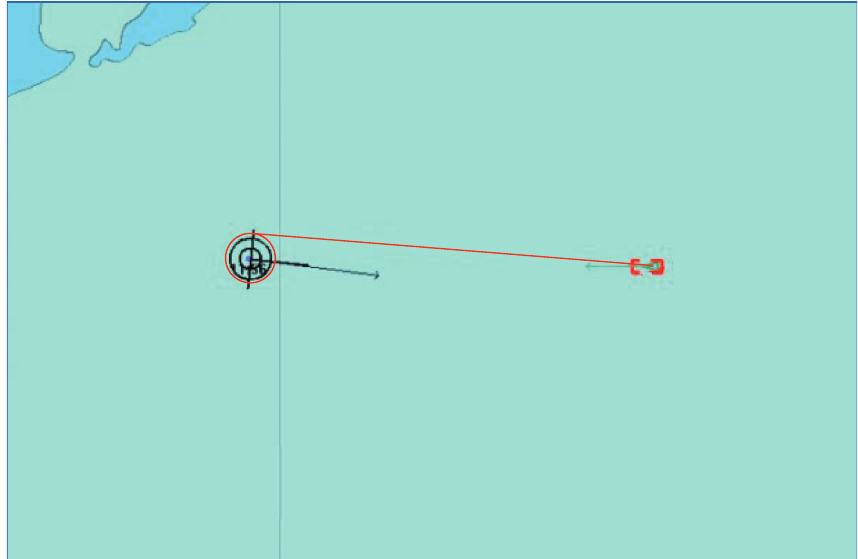
Figure 24: Own ship is facing the ship.